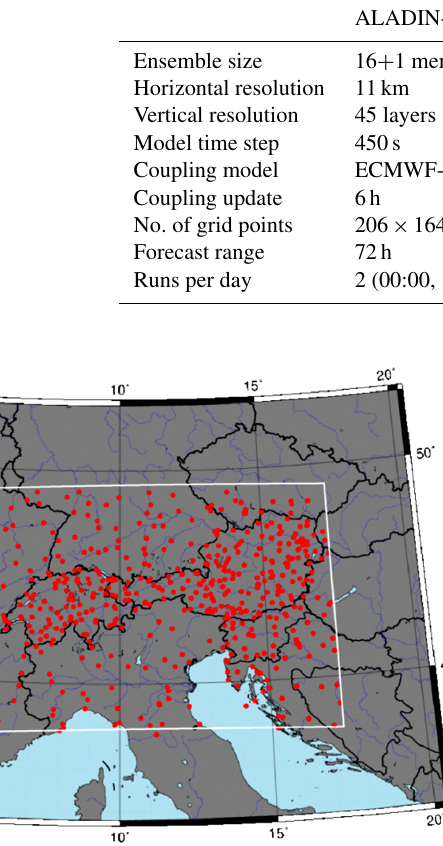
Figure 2. Locations of meteorological surface observation stations within the evaluation